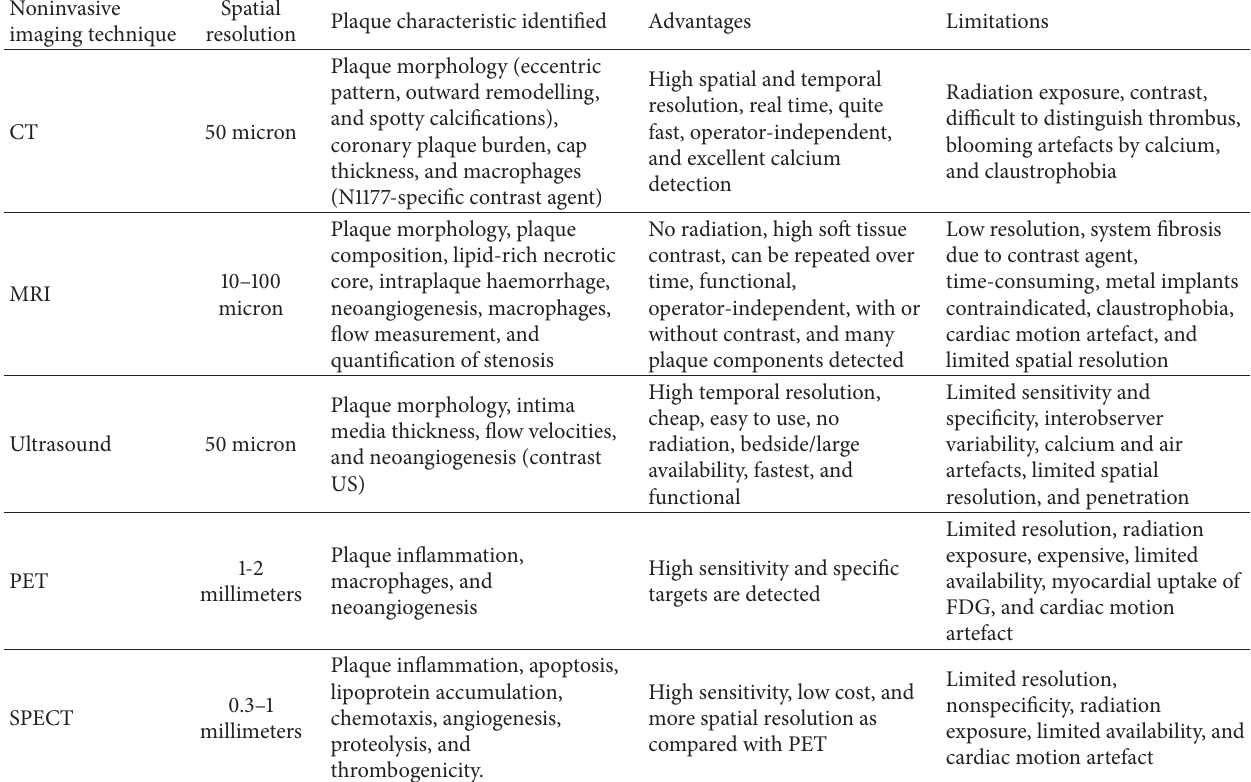
Table 1: Noninvasive imaging modalities to detect a vulnerable